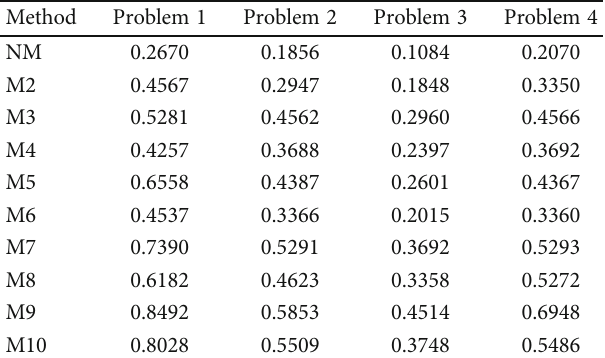
Table 1: Values of CR1 for methods 1-10 to solve all test problems, and n = 100 .